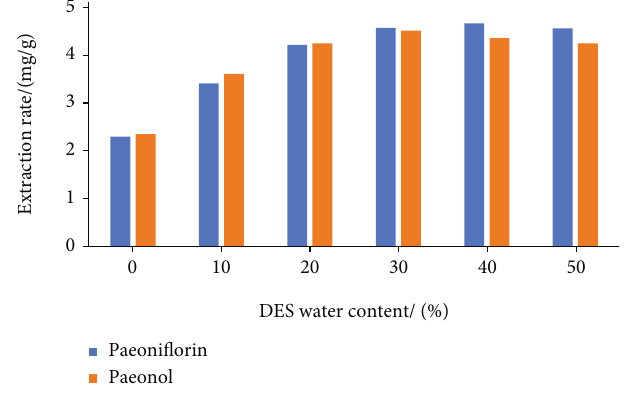
Figure 3: E ff ect of DES water content on Moutan Cortex extraction e ffi ciency.